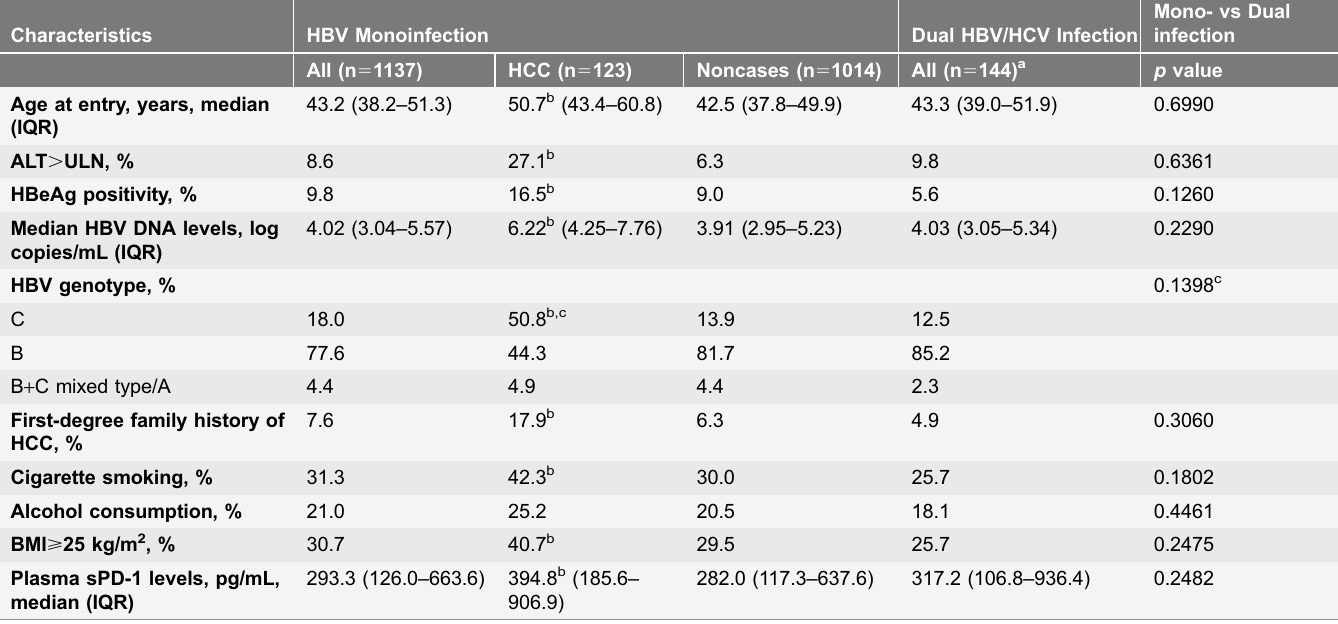
Table 1. Baseline characteristics of study participants in the case-cohort study according to infection status.